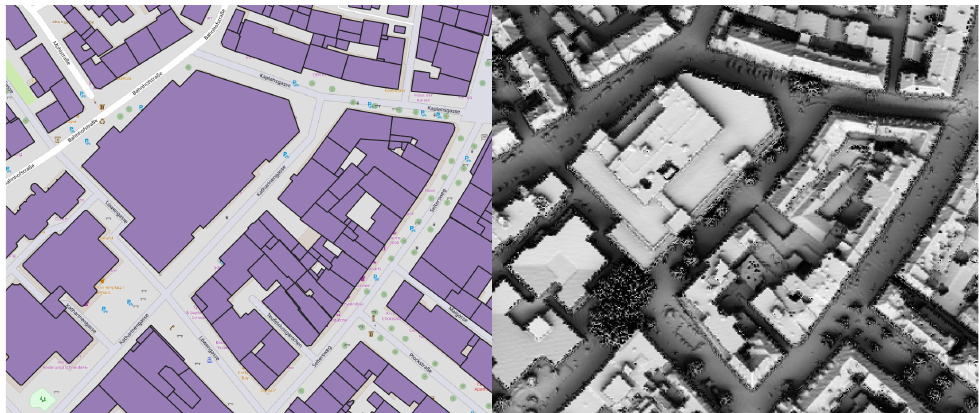
Figure 2. Representation of the data sets used. Irradiation data on the ( left ) and building ground area polygons on the ( right ), Open Street Map in the background (reprinted/adapted with permission from Ref. [40]. Copyright 2019, licensed under the Open Data Commons Open Database License (ODbL) by the OpenStreetMap Foundation (OSMF).